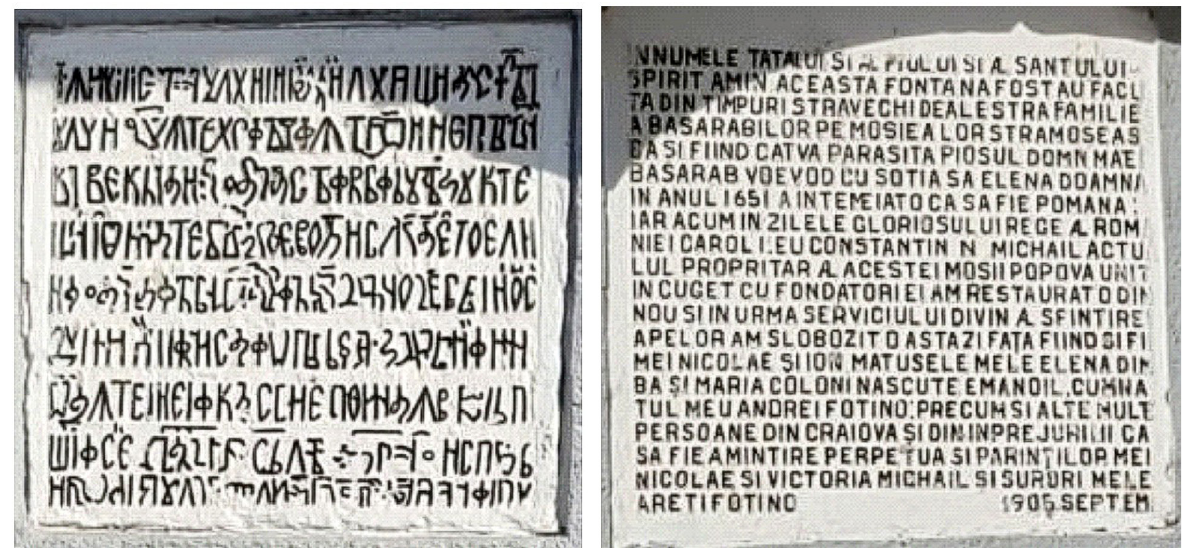
Fig. 10b. Current form of inscriptions from 1651–1652 and